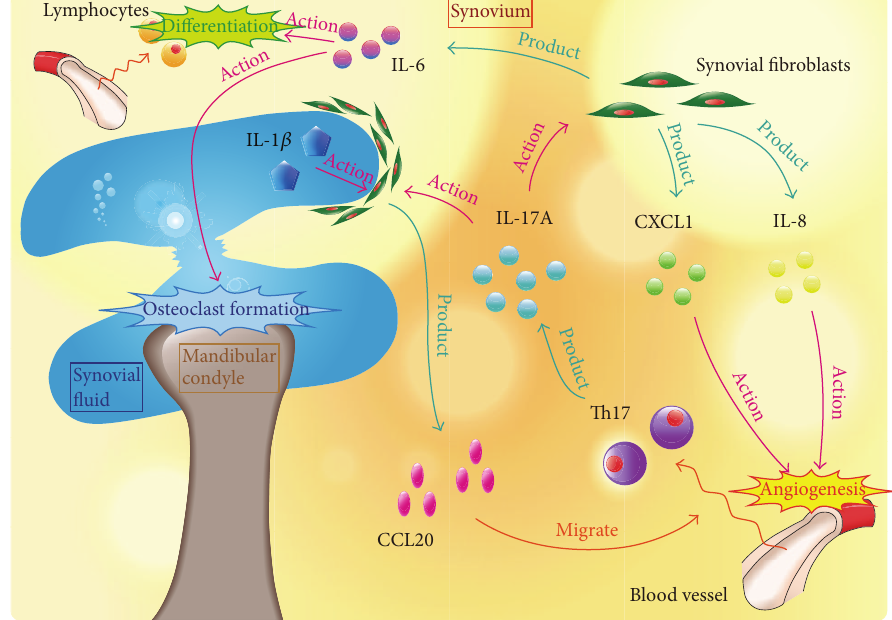
Figure 10: Summary of the TMJ inflammatory condition mediated by